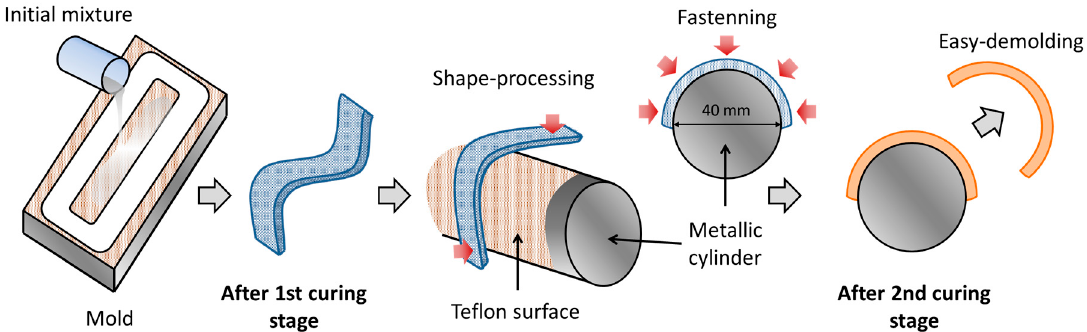
Figure 1. Illustration of the bent-shaped sample processing: from the initial liquid mixture to the final solid bent-shaped material.